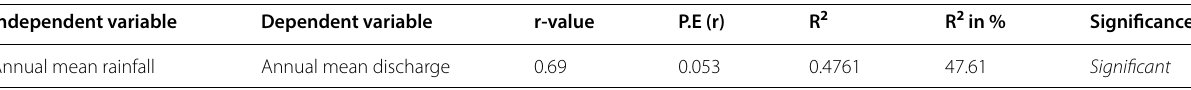
Table 5 Correlation between mean discharge and mean rainfall from 1973 to 2016 Independent